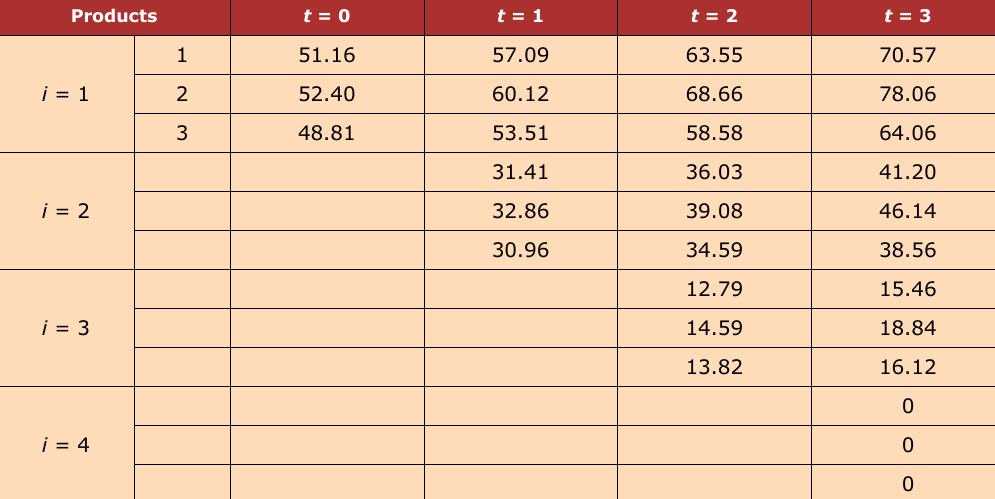
Table 4. Option Value for